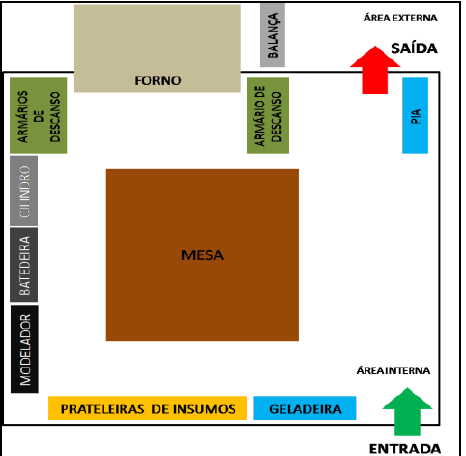
Figura 5: Diagrama de Rede com tempos mais cedo e tardes. Fonte: Autores, (2018).